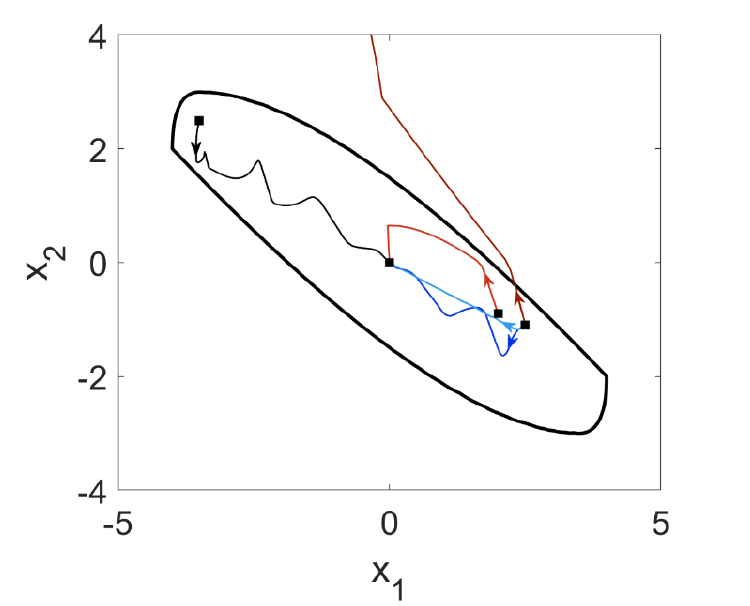
Figure 2. Evolution of the state trajectory of the multiple input multiple output liner system under various choices of the Lyapunov function. V = V Q with q = 1 and R = (cid:2) 2 (cid:3) of x 0 = ( light red ) and from an initial condition x 0 = − 0.9 (cid:2) 0 0 (cid:3) and R = (light blue) and with q = 10.2 and R = 0 0 (cid:2) 0.82 0 (cid:3) q = 10.2 and R = from an initial condition of x 0 = 0 0.82